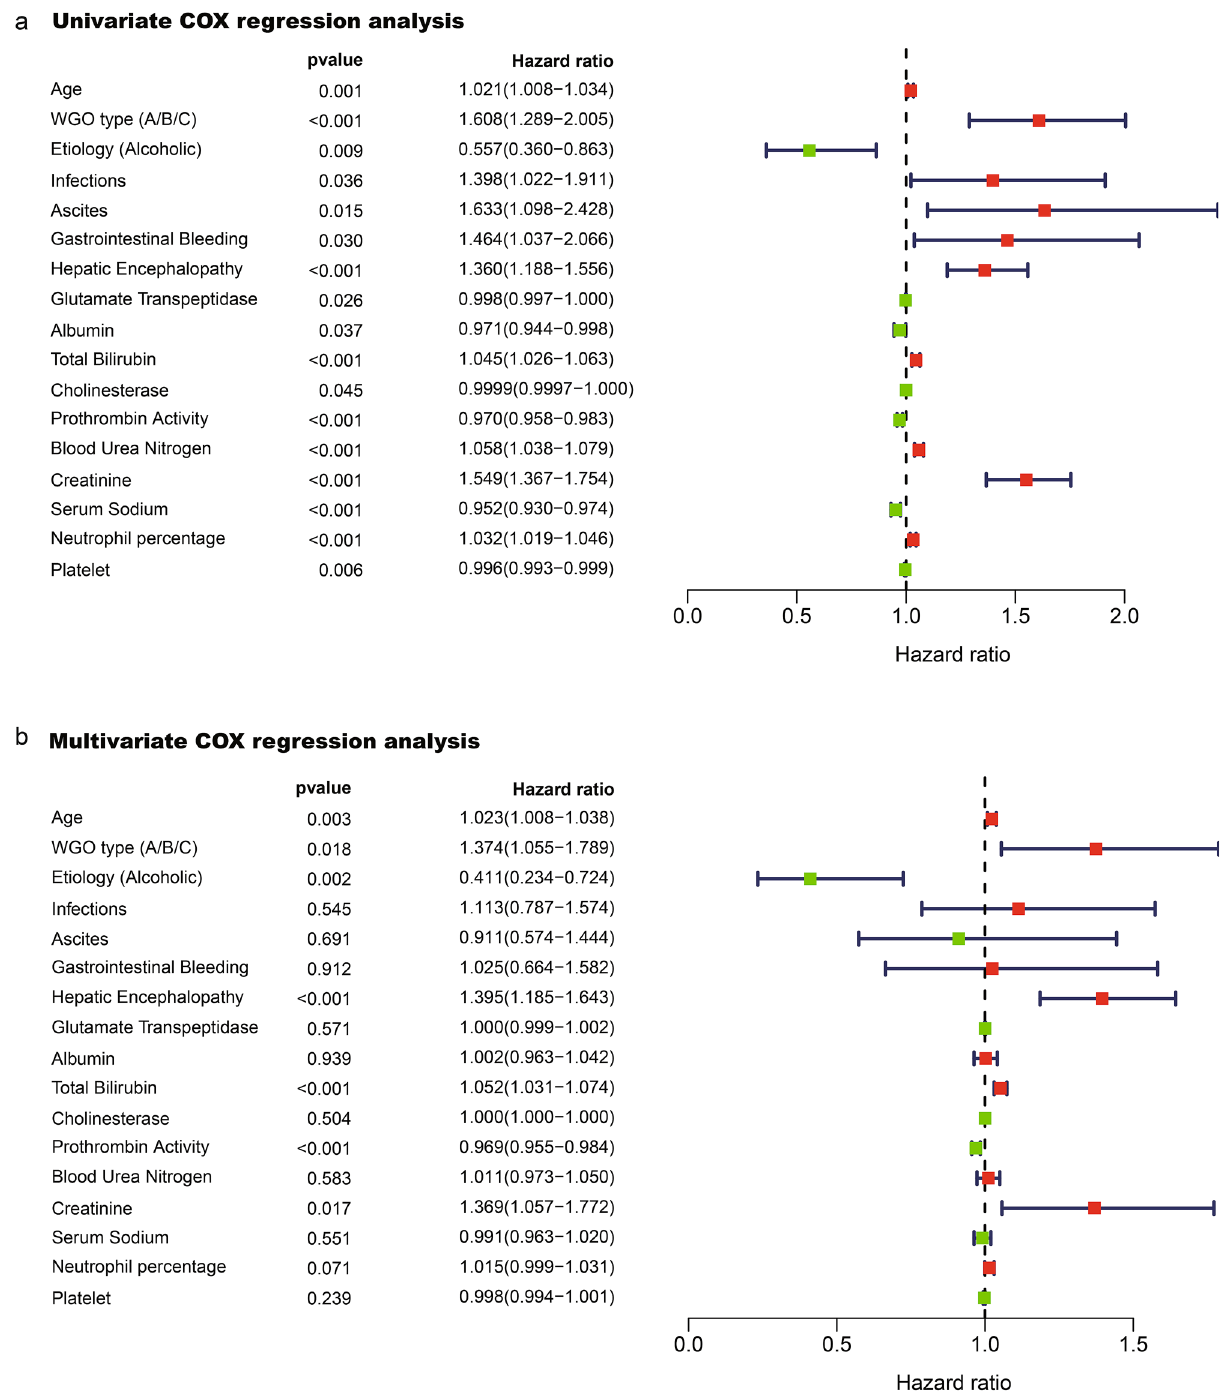
Figure 2. ( a ) Univariate Cox regression analysis showing that the factors related to ACLF prognosis were age, WGO type, basic etiology, bacterial infection, ascites, gastrointestinal bleeding, hepatic encephalopathy stage, glutamate transpeptidase, albumin, total bilirubin, cholinesterase, prothrombin activity, blood urea nitrogen, creatinine, serum sodium, neutrophil ratio, and platelets. ( b ), Multivariate Cox regression analysis confirmed that age, WGO type, alcoholic etiology, total bilirubin, creatinine, prothrombin activity, and hepatic encephalopathy stage remained associated with prognosis of ACLF. (Assignment of indexes in COX regression analysis was as follows: WGO type A, B, and C of ACLF were assigned 1, 2, and 3 respectively; basic etiology was assigned 1 for the alcoholic liver disease alone, and 0 for others; positive complications including bacterial infection, gastrointestinal bleeding, ascites were all assigned 1, no complications 0; hepatic encephalopathy was assigned 0, 1, 2, 3, and 4 according to the West Haven stages 0, I, II, III, and IV, respectively; artificial liver system support (ALSS) was assigned 1, no ALSS